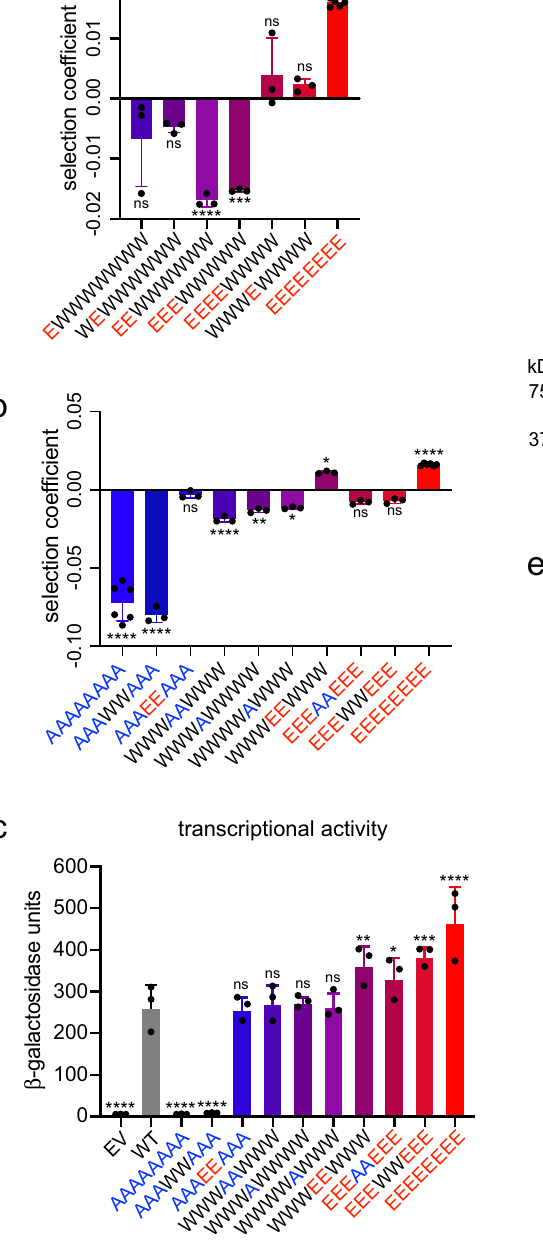
Fig. 6 | Phosphorylation of sites 460 and 471 depends on upstream CDK sites. a , b Selection coef fi cients of the indicated mutants from the WT/E screen ( a )